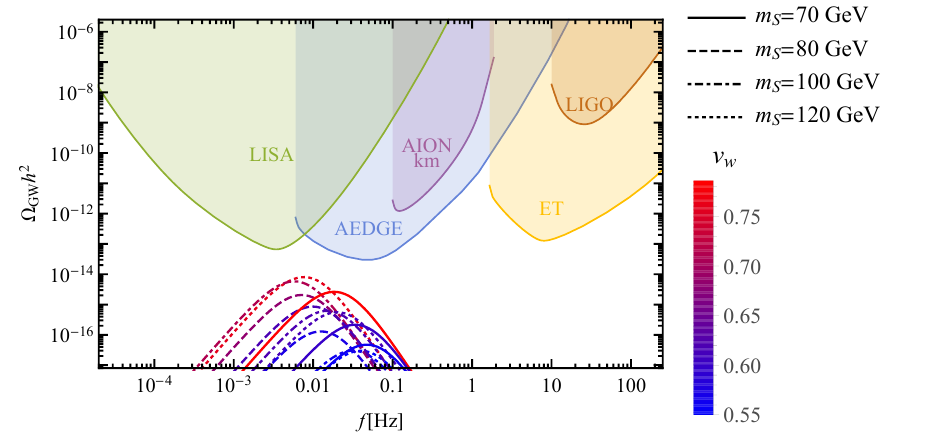
Figure 15 . Gravitational wave signals for a range of parameters starting with the strongest transi- tions in the SM plus neutral scalar model together with power-law integrated sensitivities of current and upcoming